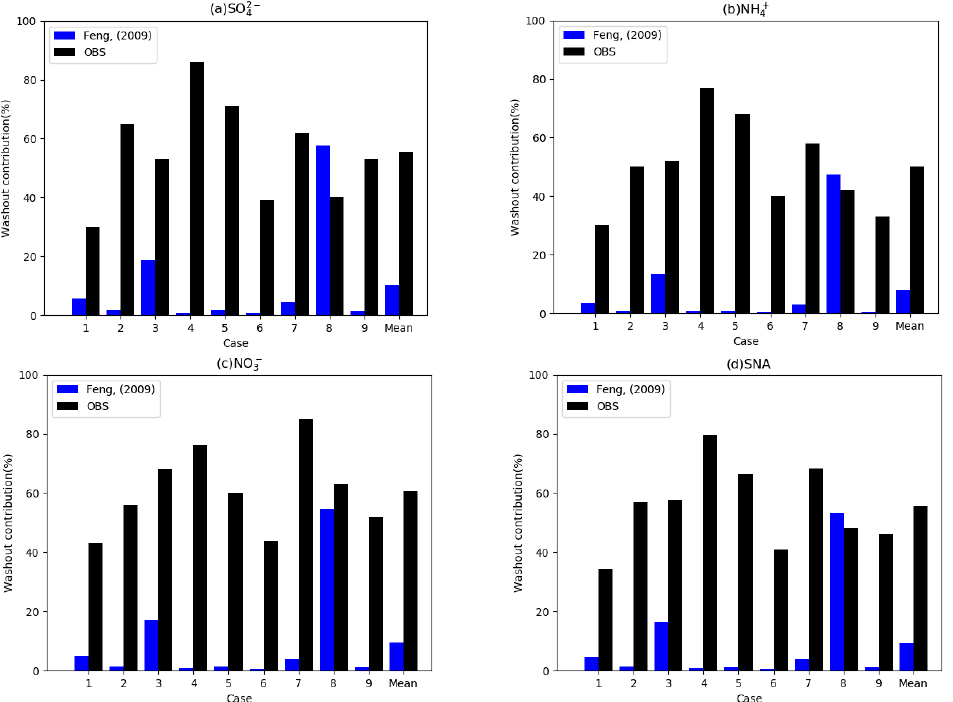
Figure 3. Observed washout contribution (%) from the total wet deposition flux for nine cases observed by Xu et al. [25] (black bars) and simulated washout contribution with wet scavenging coefficients suggested by Feng [35,36] (blue bars). Each figure denotes ( a ) washout contributions of SO 42 − , ( b ) NH 4+ , ( c ) NO 3 − , and ( d ) the average of the three species.